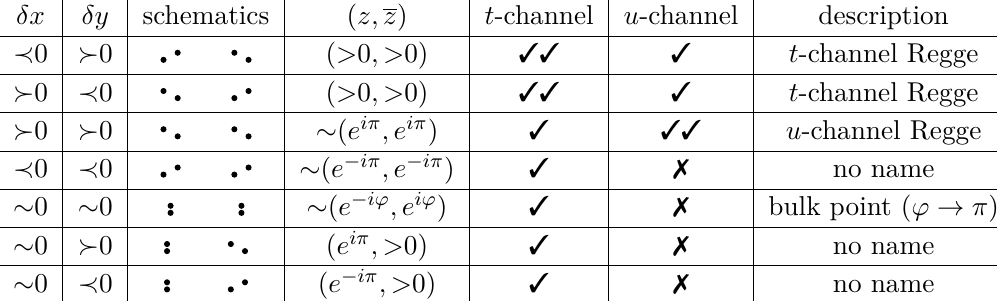
Table 1 . Various kinematic regions classified by whether the small vectors δx, δy are future timelike ( (cid:31) 0 ), past timelike ( ≺ 0 ) or spacelike ( ∼ 0 ), showing the phase of small cross-ratios. The schematics are meant to visually evoke positions along the timefold (3.3). The double check marks indicate exponential convergence of an OPE, single check marks indicate marginal (distributional) convergence, and 7 indicates that an OPE does not converge. ϕ is the angle between δx and −I e · δy . In the second step we move z all the way to the left of z . This is more interesting as 4 3 not all the singularities are on the same